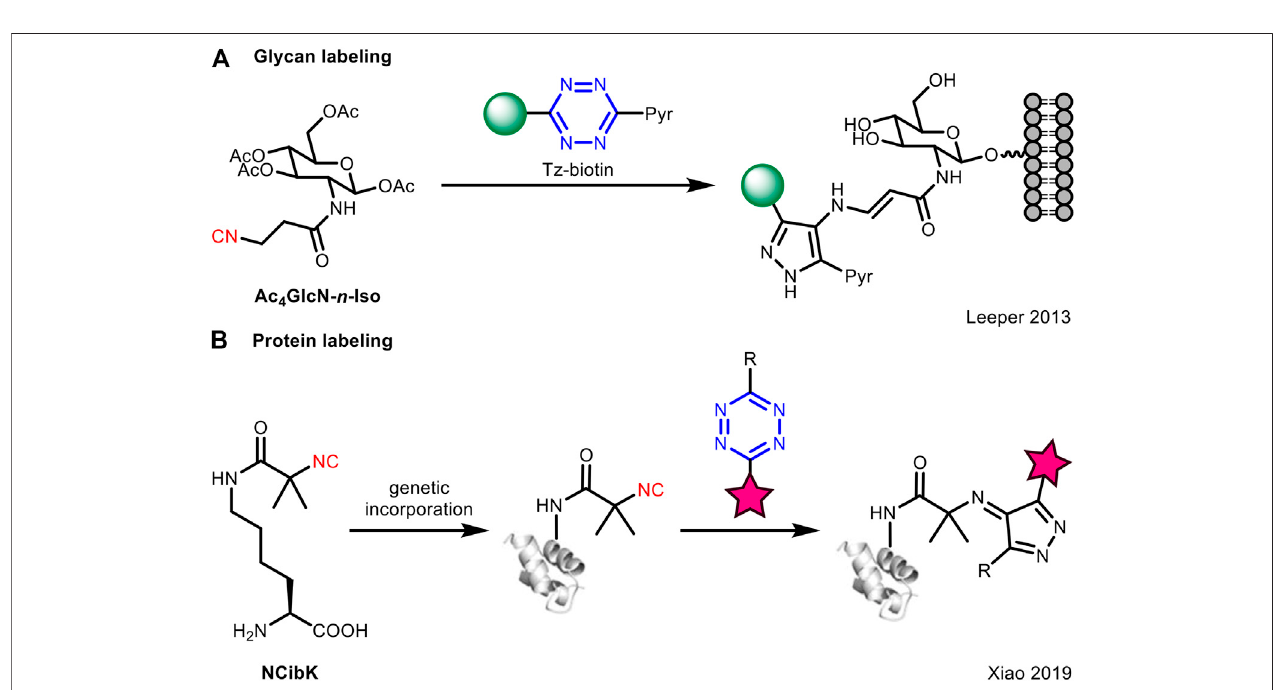
FIGURE 3 | Application of isocyanide-tetrazine chemistry for bioorthogonal ligation with (A) glycans or (B) proteins.